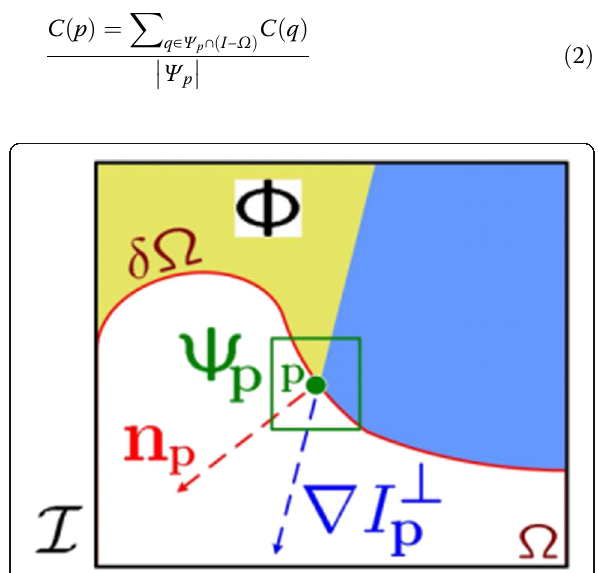
Scanning sequence of the most similar symmetrical exemplar Left to right, bottom to top Top to bottom, left to